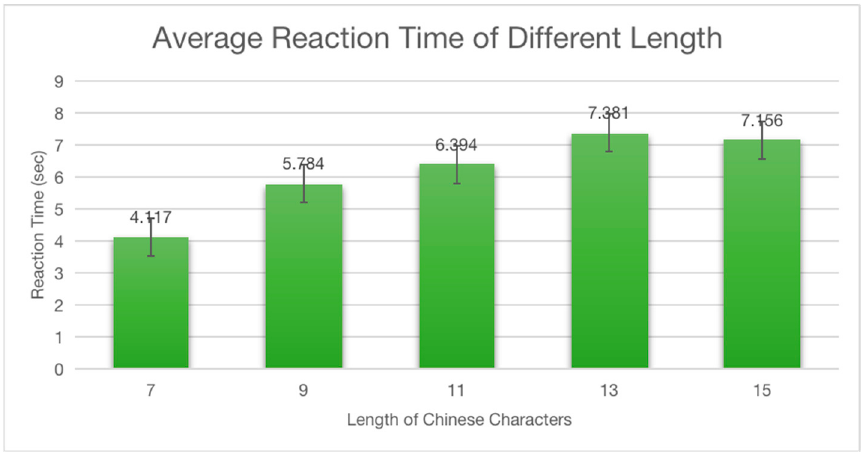
Figure 4. Average reaction time of Chinese characters’ different length.